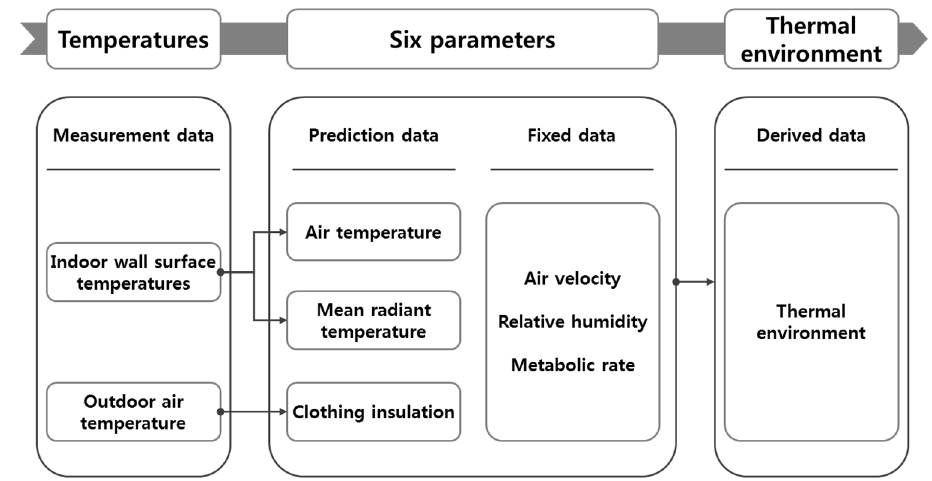
Figure 2. Input/output data for predicting thermal environment.